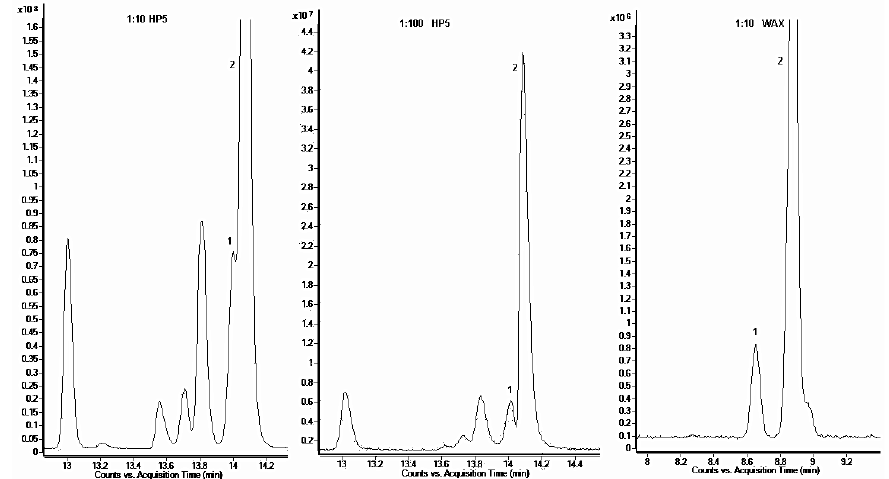
Figure 1. Comparison of limonene (1) and eucalyptol (2) peak separation, between the HP-5MS column at a dilution of 1:10 ( v/v ) or 1:100 ( v/v ) and the SupelcoWAX TM 10 column at dilution 1:10 ( v/v ).